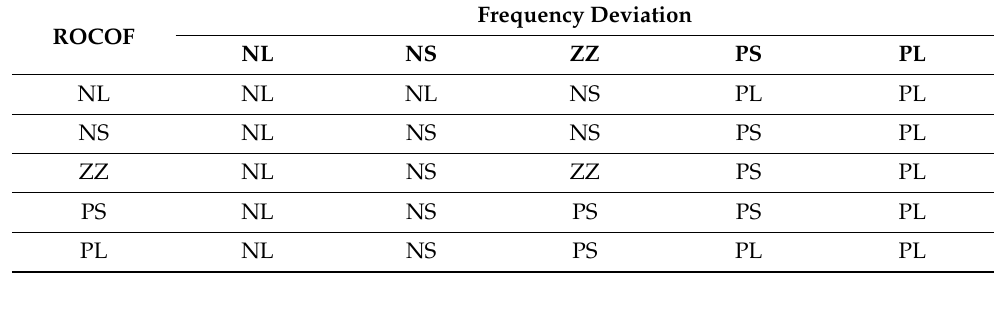
Table 3. Fuzzy rule base for the proposed control system.